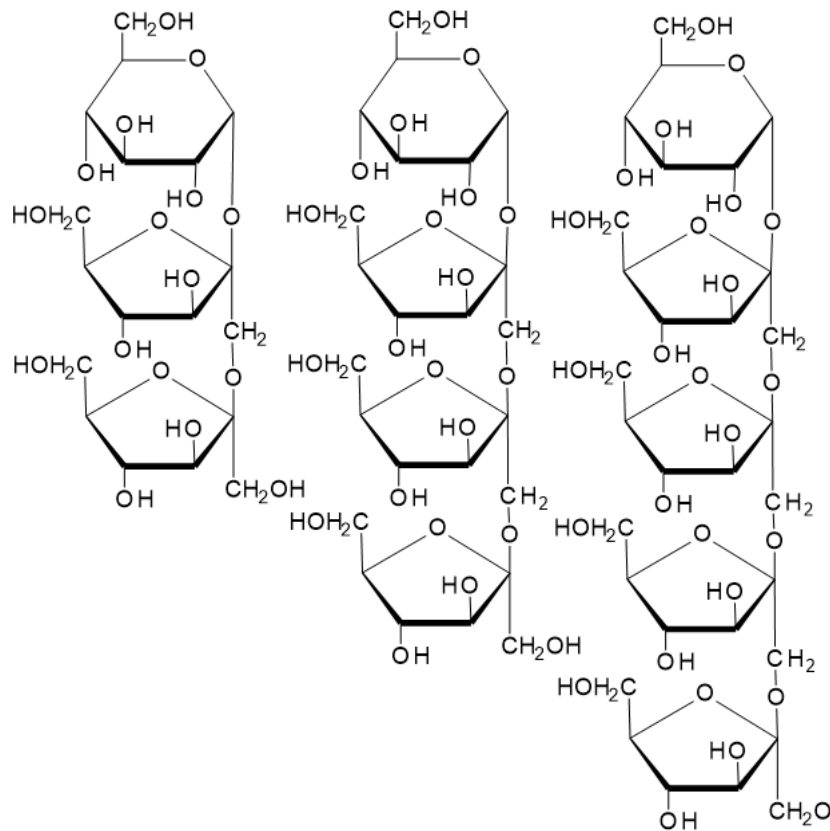
Figure 3. Chemical structure of scFOS produced from sucrose: 1-ketose, nystose, and 1F-fructo- Chemical structure of scFOS produced from sucrose: 1-ketose, nystose, and 1F- furanosyl nystose. fructofuranosyl nystose.